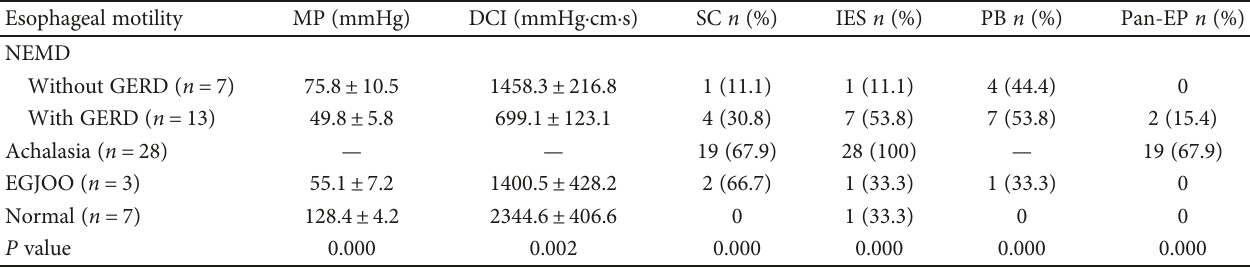
Table 2: Results of esophageal manometry in 58 NOD patients — esophagus body. Esophageal motility